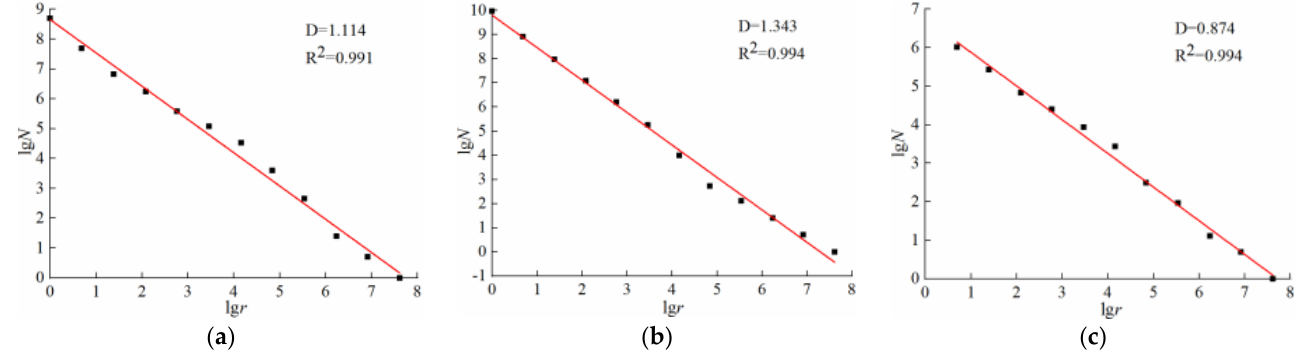
Figure 14. Fractal dimension of fractured three zones in mining rock. ( a ) Falling zone; ( b ) Crack belt; ( c ) Curving belt.